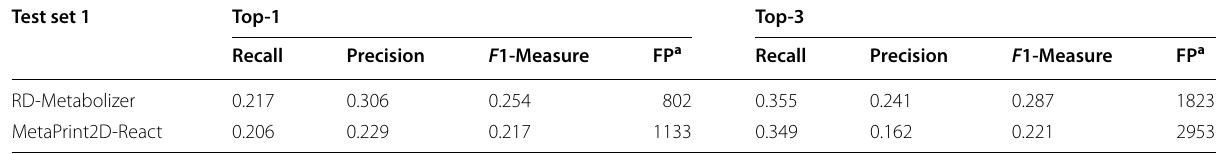
a FP is the total number of predicted false positive metabolites in the top- k ( k